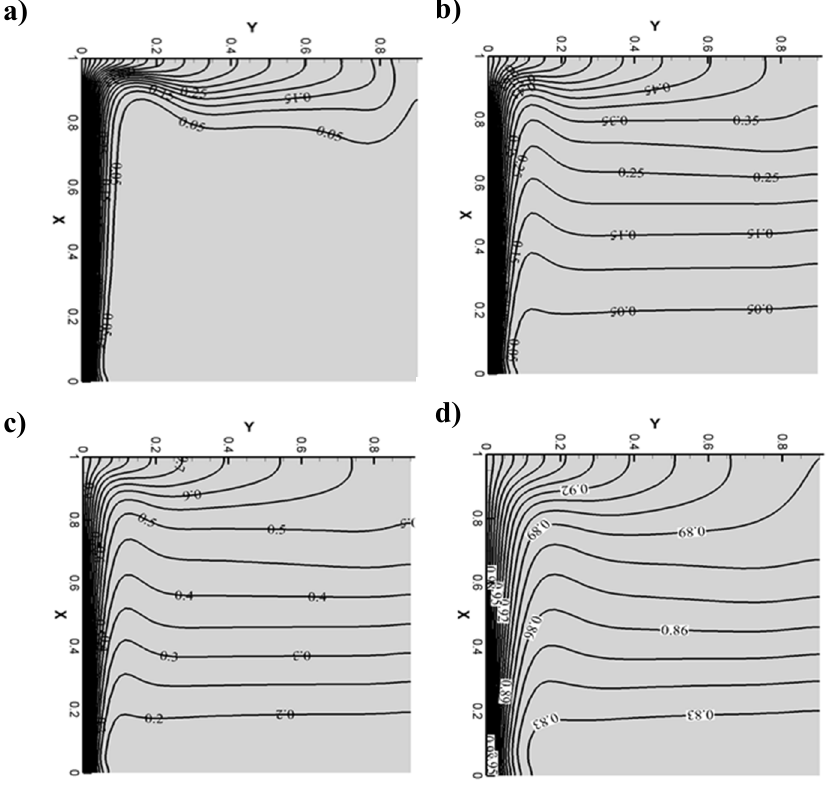
Figure 3. Streamlines for Ra = 10 6 and R in = 0.1.